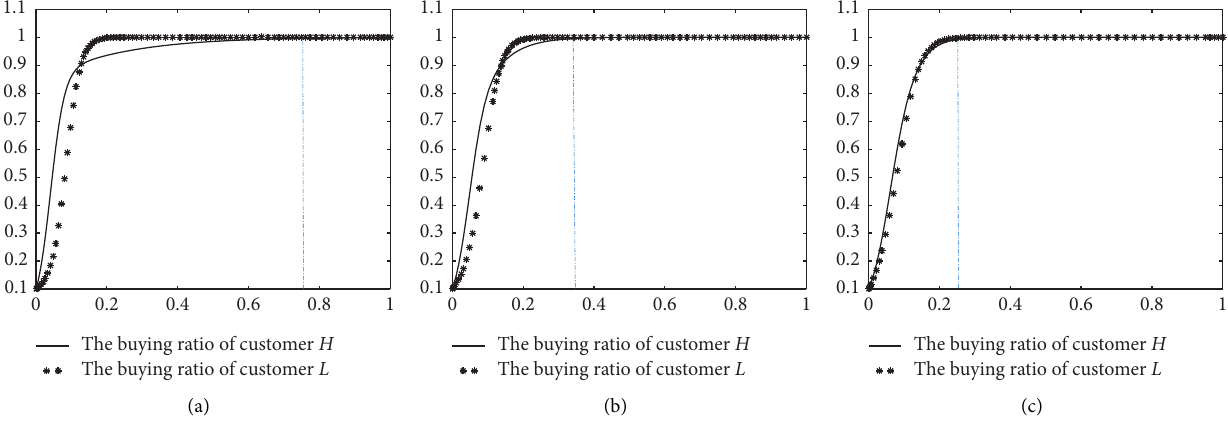
Figure 6: System evolution at different values of k under the premise of P < (( 2 − k ) S − r ) /2. (a) k � 0.25. (b) k � 0.15. (c) k �